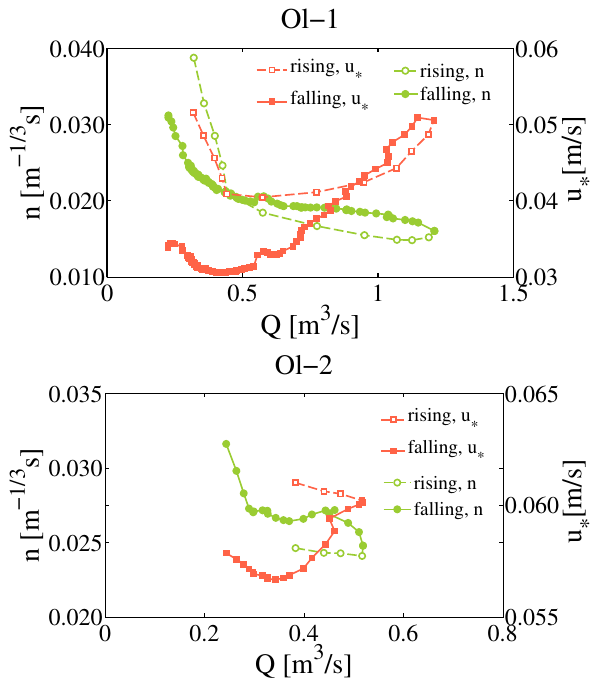
Figure 12. Comparison of the relation of n vs. flow rate Q and friction velocity u ∗ vs. Q along rising and falling limbs of waves for experimental flood waves in the Olszanka